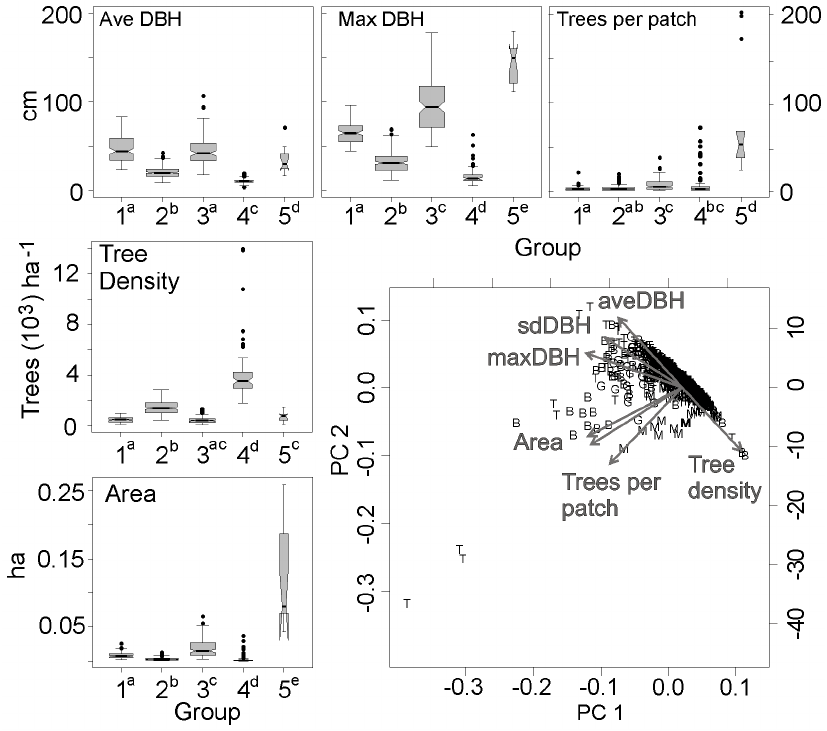
Figure 11. Proportion of 534 tree patches sorted by group number from four old-growth forest plots. A group represents a set of tree patches with similar forest characteristics interpreted using cluster analysis (see Figure 10).